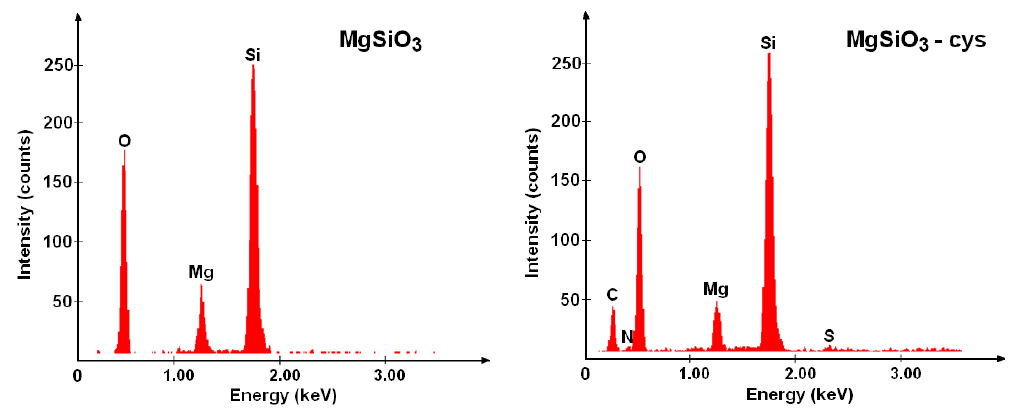
Figure 4. Energy dispersive X-ray (EDX) spectra for MgSiO 3 and MgSiO 3 -cys materials.